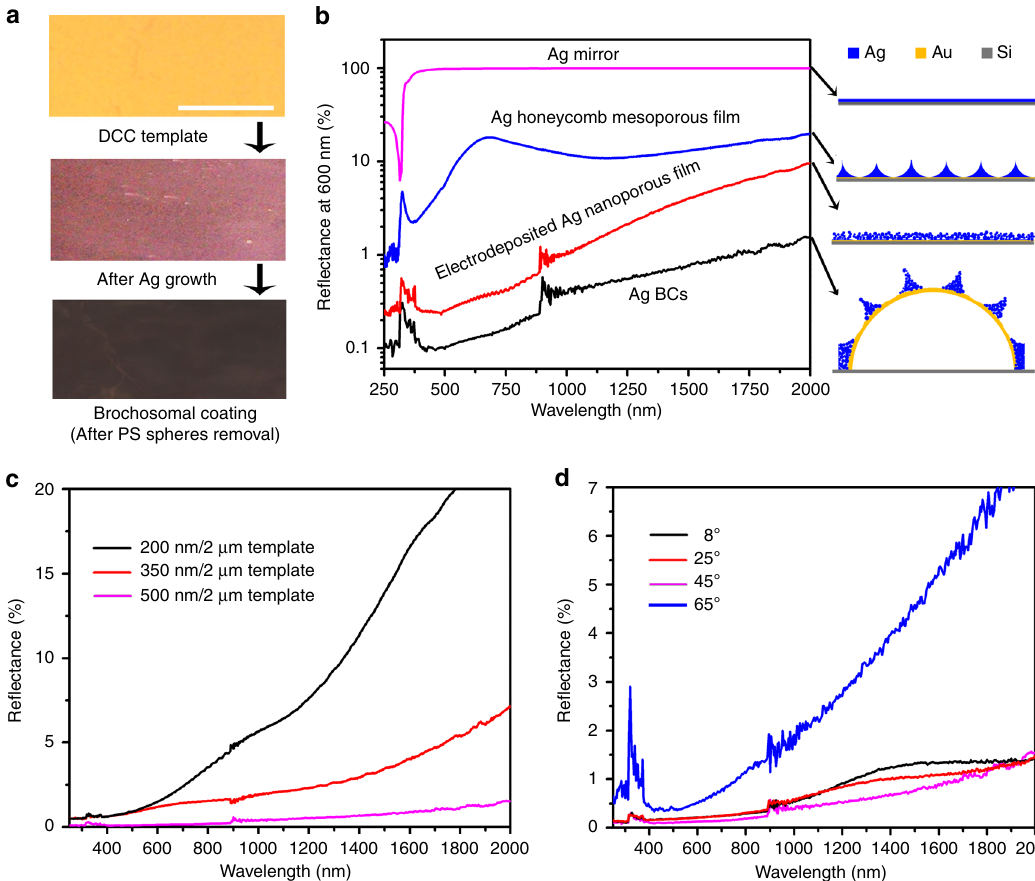
Fig. 4 Antire fl ection performance of the synthetic BCs. a Optical images of DCC template before and after Ag electrochemical growth, and after the removal of PS beads. Scale bar: 5 mm. b A plot showing the re fl ection spectra of Ag mirror (in magenta), Ag honeycomb mesoporous fi lm (in blue), Ag nanoporous fi lm (in red) and Ag BCs (in black). Schematic drawings of the corresponding structures are shown on the right. The Ag BCs were prepared by using the DCC template composed of 2 µ m large PS spheres with the top surface covered by 500 nm PS spheres. After electrodeposition, the pits of these BCs were 470 nm in opening size and 260 nm in depth. The Ag honeycomb mesoporous fi lm was prepared by electrodeposition using 500 nm PS spheres on an Au-covered silicon wafer. The depth of the pits was ~250 nm (Supplementary Fig. 14). c A plot showing the re fl ection spectra of BCs with different pit sizes. d A plot showing the angle dependence of the re fl ection spectra of the Ag BCs composed of 2 µ m particles with pits 470 nm in opening size